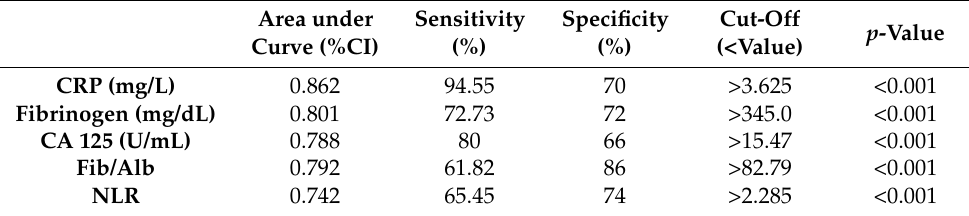
CA: Cancer antigen; CRP: C-reactive protein; Fib/Alb: Fibrinogen/Albumin. NLR: Neutrophil– lymphocyte ratio.